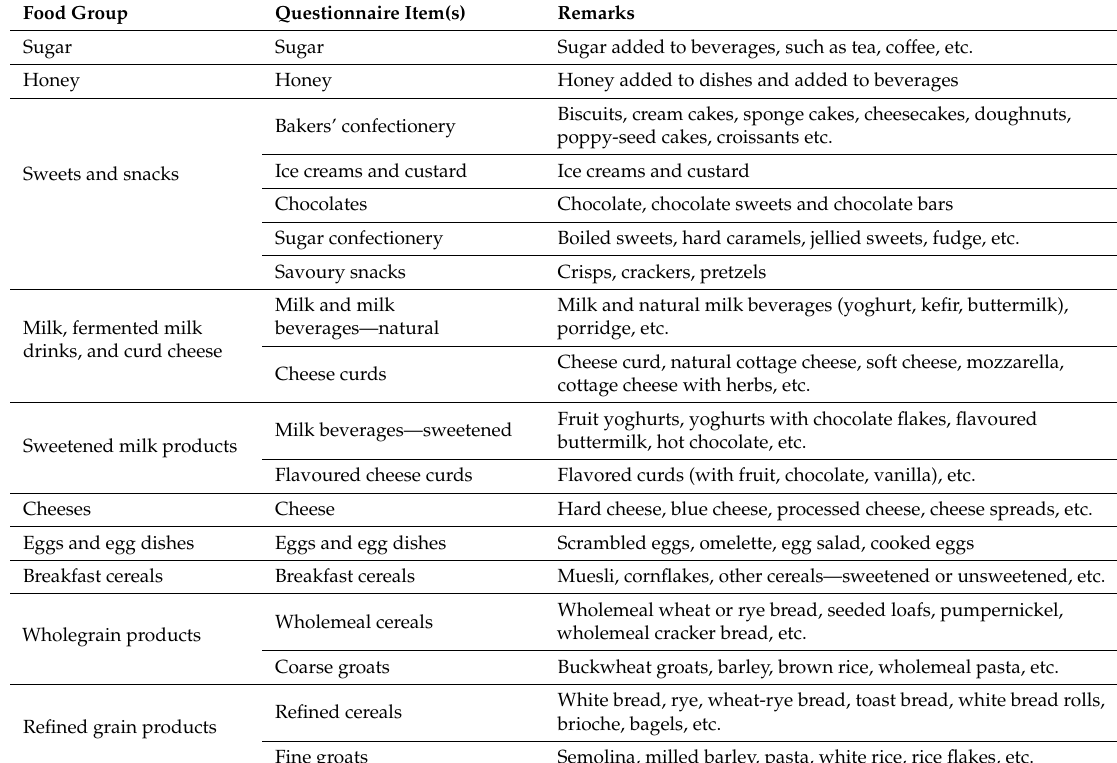
Table 1. Food groups used in dietary patterns